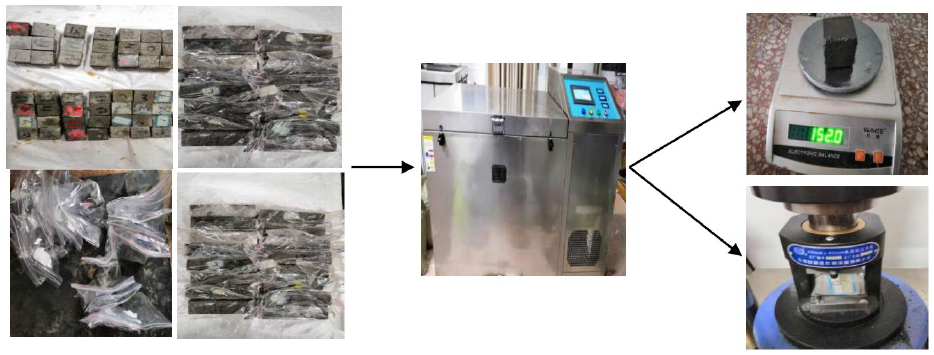
Figure 5. Apparatus and process of freeze-thaw cycle test.